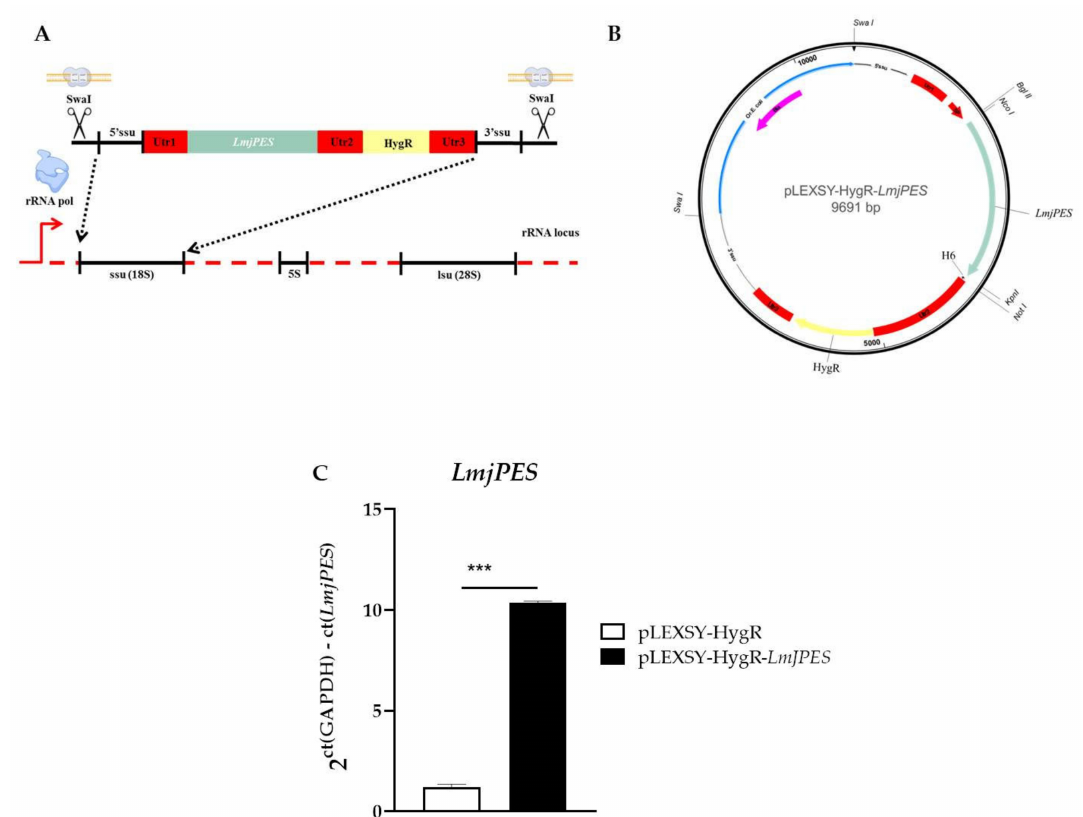
Figure 6. Generation of Leishmania major strains overexpressing LmjPES . ( A ) Schematic representation of the approach to overexpress LmjPES by the integration of pLEXSY-HygR plasmid harboring LmjPES sequence (pLEXSY-HygR- LmjPES ) in the 18S rRNA locus. ( B ) Map of the integrative plasmid carrying the LmjPES sequence used to generate overexpressing parasites. ( C ) LmjPES gene expression level of transgenic L. major strains (pLEXSY-HygR- LmjPES ) compared to L. major control (pLEXSY-HygR) parasites. The LmjPES expression level of recombinant parasites was checked by quantitative real-time PCR (qPCR) and represented (*** p <